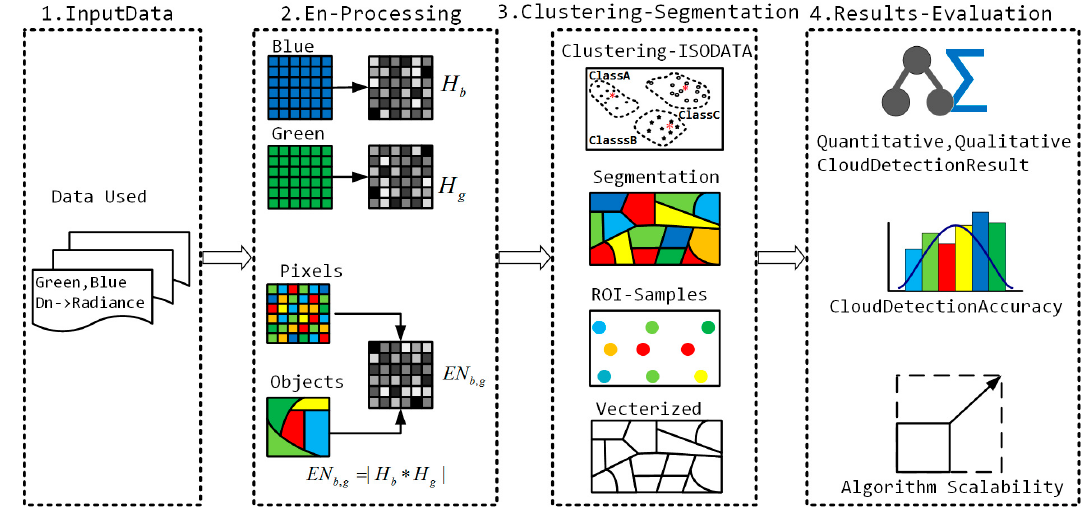
Figure 2. Flowchart of the EN-Clustering algorithm.